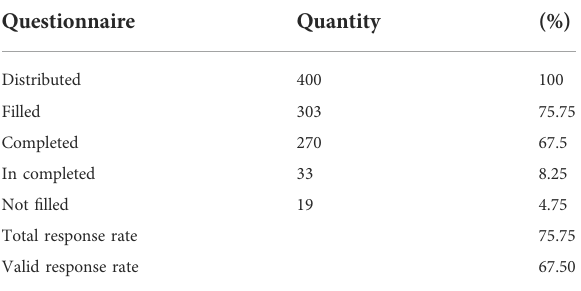
TABLE 1 Questionnaires response